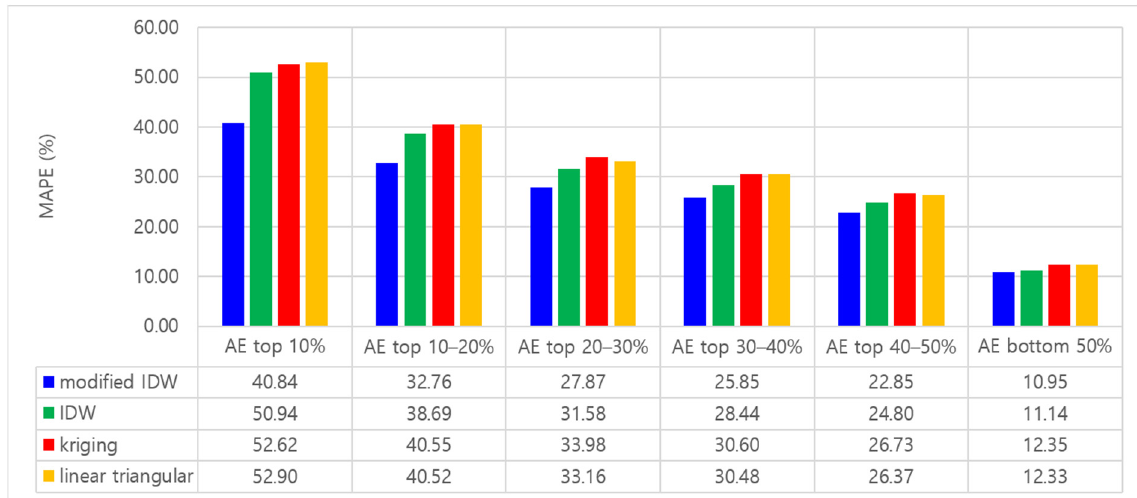
Figure 8. MAPE levels of estimated PM2.5 for different algorithms based on AE levels.